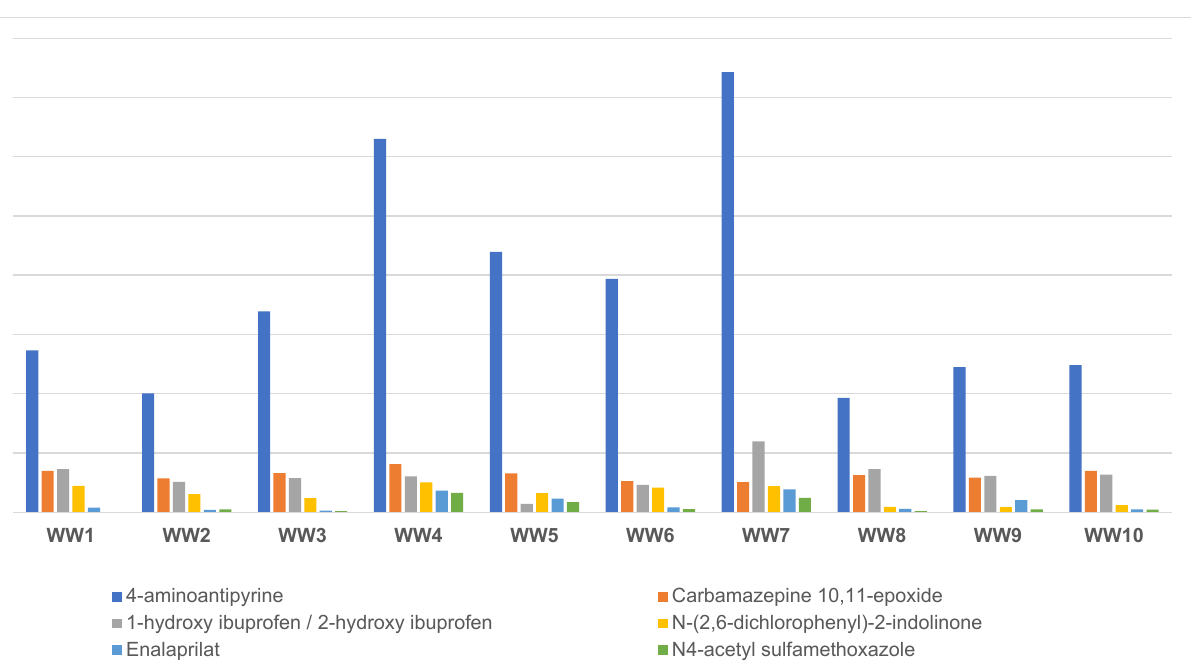
Figure 3. Concentrations (in µg L -1 ) of the target metabolites and N-(2.6-dichlorophenyl)-2-indolinone (TP of diclofenac) in wastewater samples. WW: wastewater.